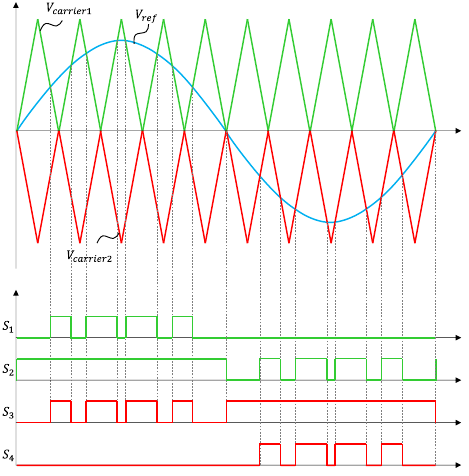
Figure 2. Switching signal waveforms of the conventional phase opposition disposition (POD) modulation scheme.